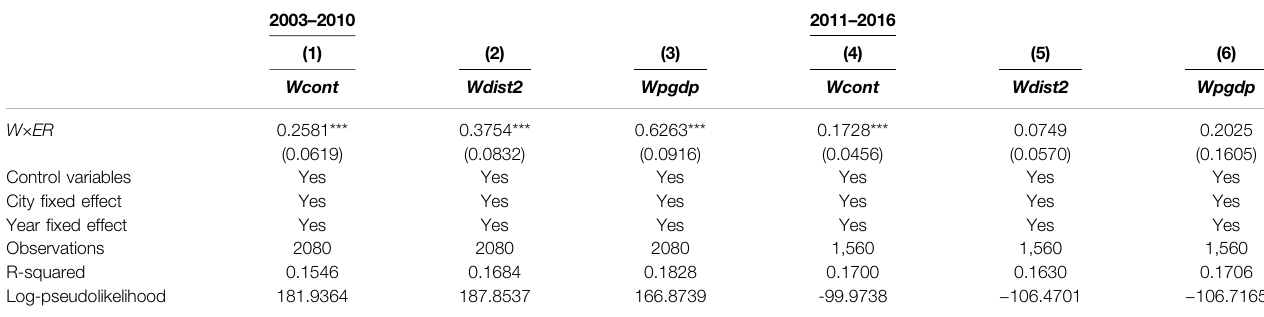
TABLE 6 | Estimates for different periods.